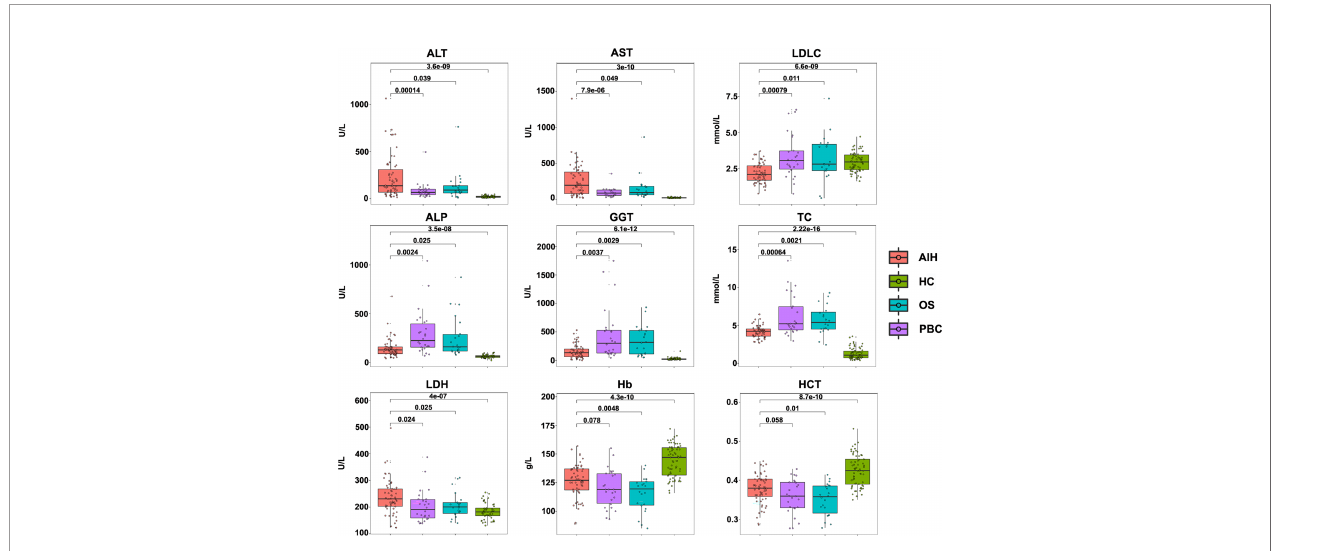
FIGURE 1 | Clinical indicators of AIH patients, PBC patients, OS patients and HC controls. Concentrations of ALT, AST, LDLC, ALP, GGT, TC, LDH, Hb and HCT level in AIH patients (n= 59), PBC patients (n= 26), OS patients (n= 22) and HC controls (n=